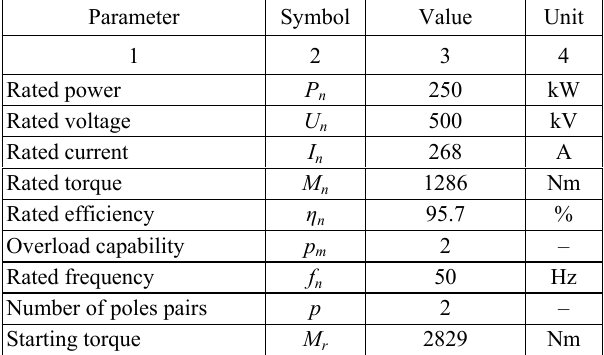
Table 3. Parameters of drive